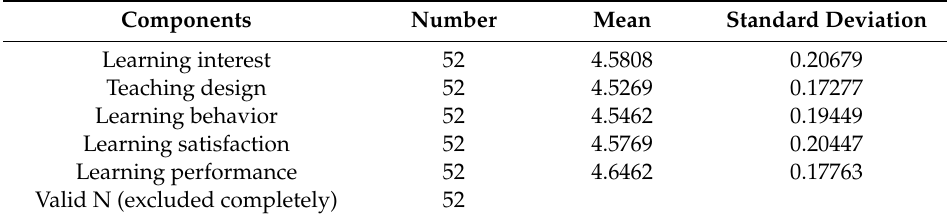
Table 6. Descriptive statistics of the ARCS model components for the experimental